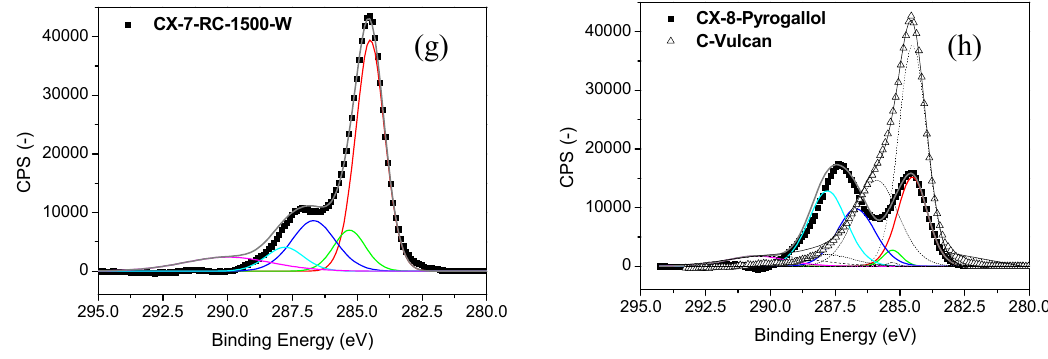
Figure 2. Raman spectra acquired for the synthetized carbon xerogels and Vulcan carbon